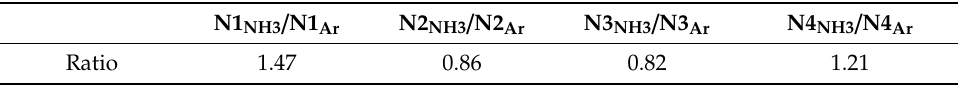
Table 4. Ratios values for Nx NH3 / Nx Ar species deduced from N1s spectra fitting of argon and ammonia treated